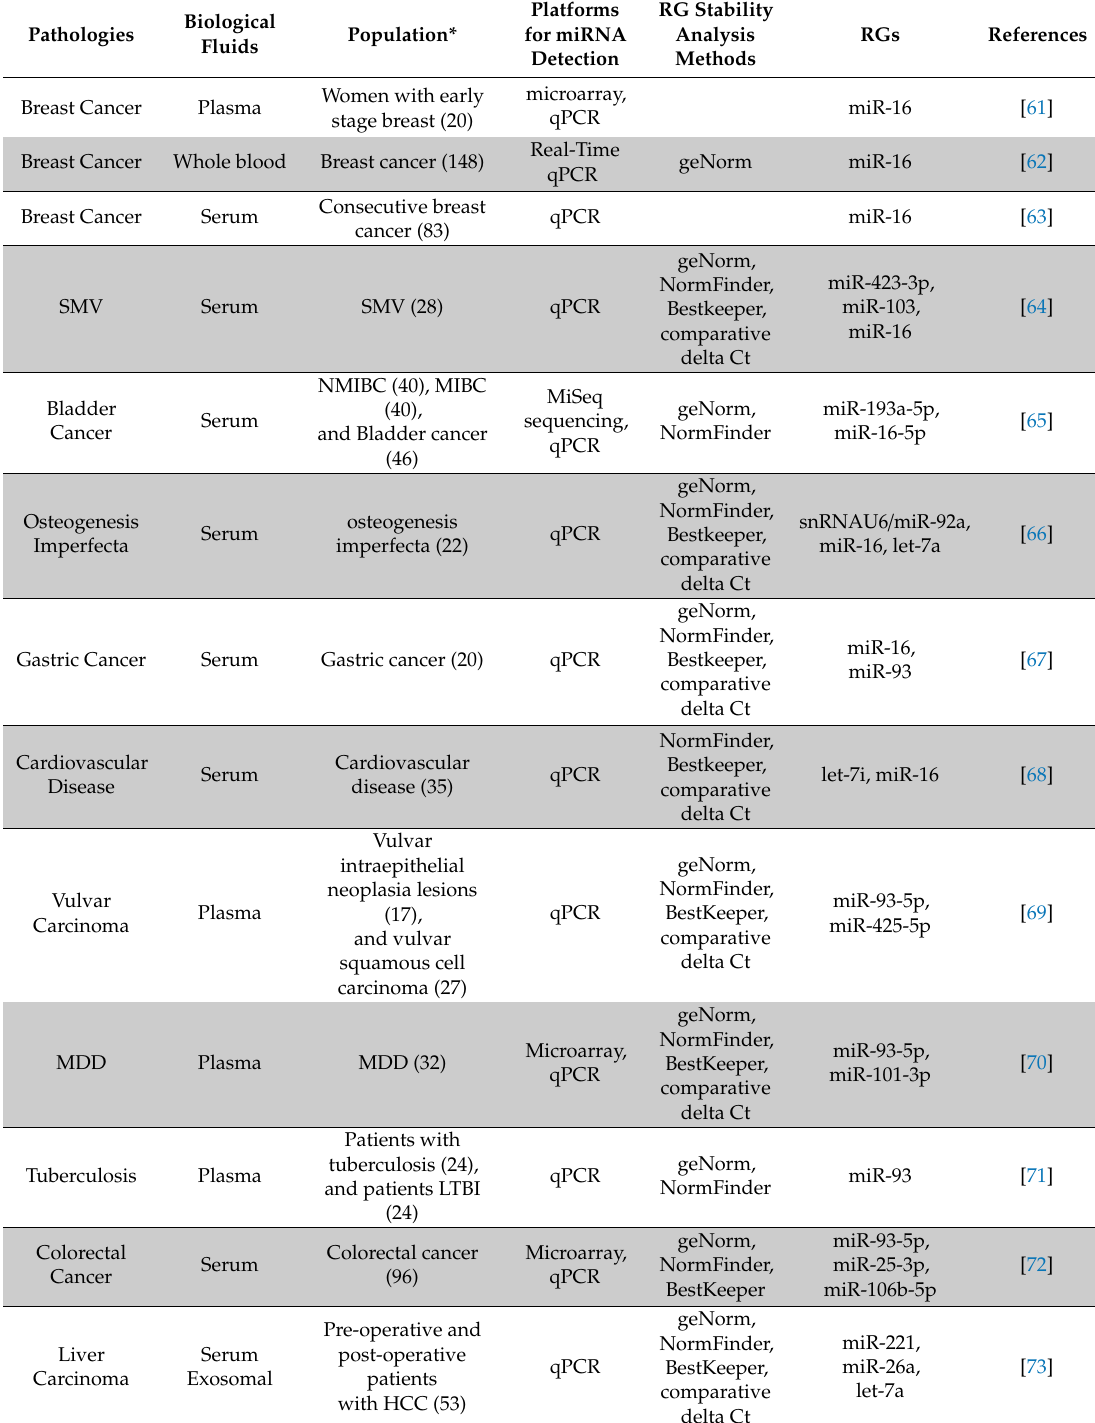
Table 1. The best identified non-coding RNAs as potential